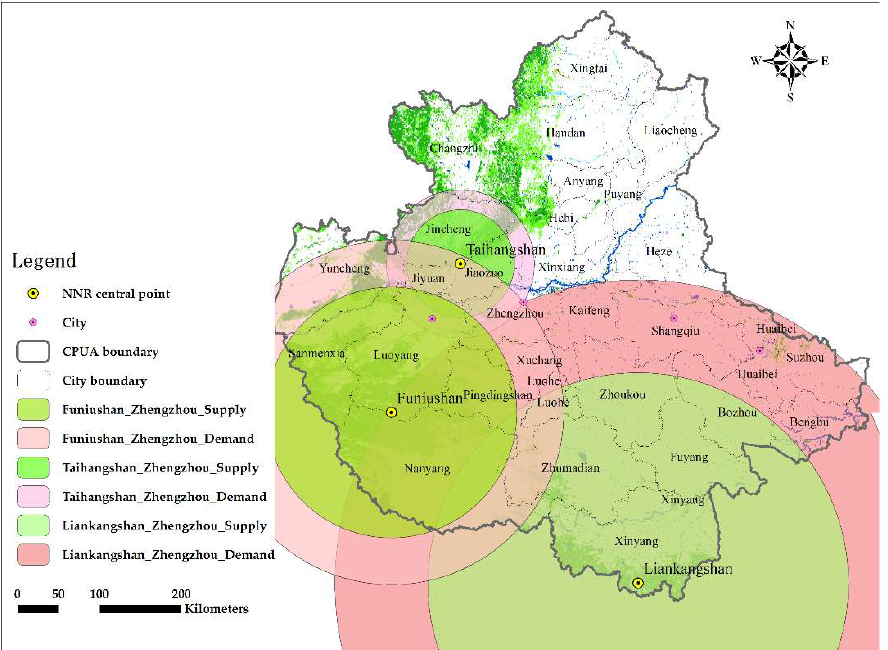
Figure 3. ES supply and demand patterns based on spatial transfer from ecospace to Luoyang.